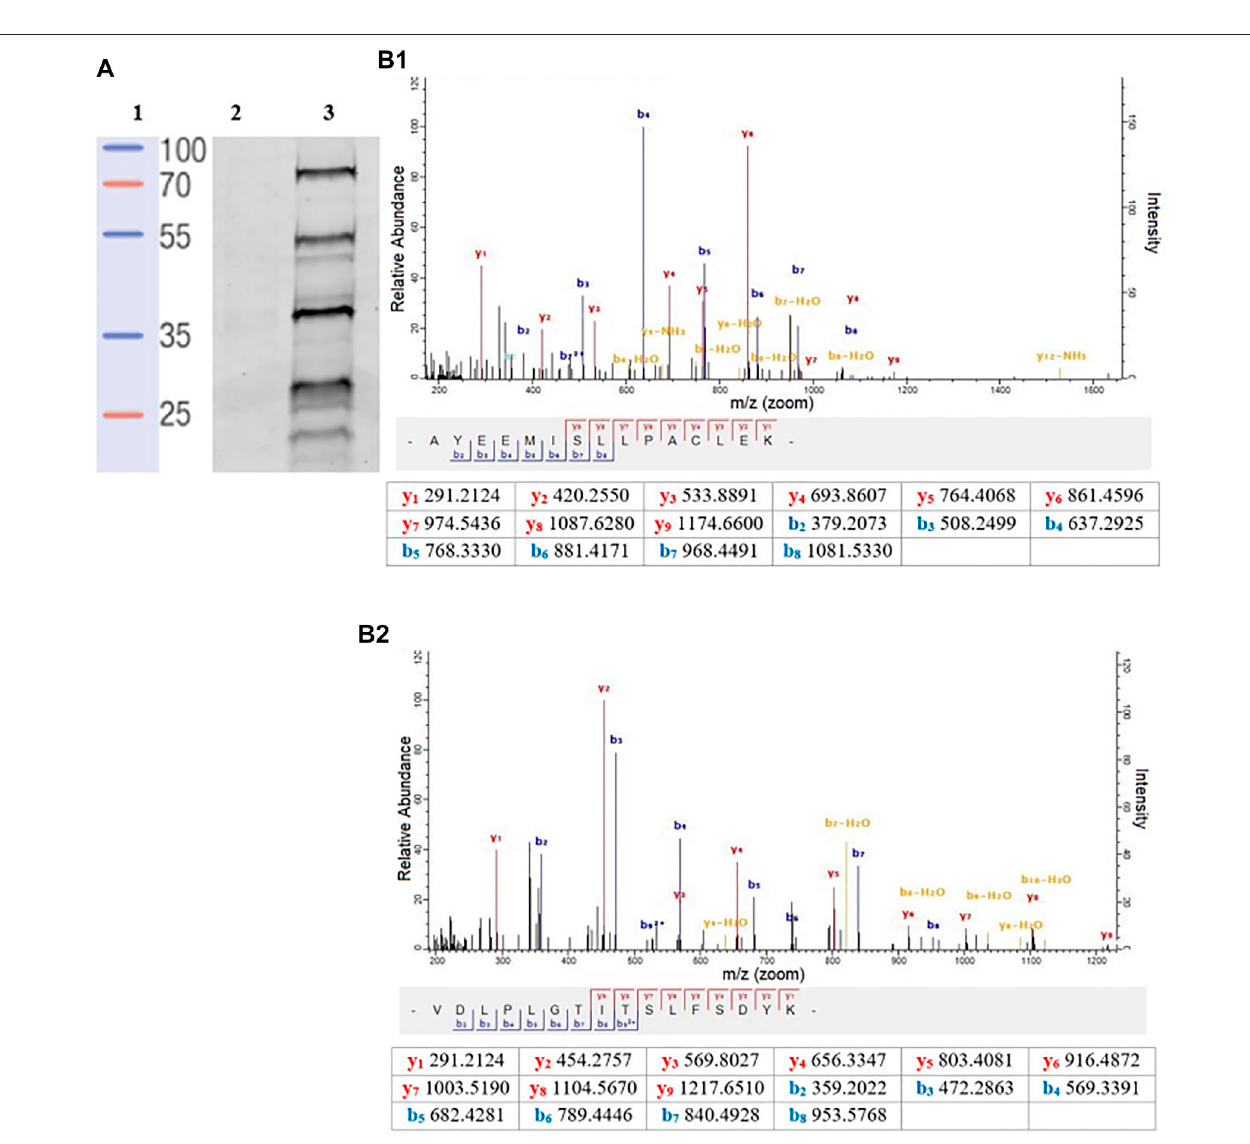
FIGURE 3 | (A) In-gel fl uorescence analysis (emission at 560 nm) of the competitive ABPP between FP-biotin conducted to compare af fi nity. Lane 1: Protein ladder. Lane 2: FP-biotin (4 μ M) was incubated in a L. mexicana promastigote lysate (1 mg/ml) for 60 min at rt. Subsequently, TAMRA-FP (1 μ M) was added, and the mixture was incubated for a further 15 min followed by SDS-PAGE and fl uorescent imaging. Lane 3: Labelling of TAMRA-FP (1 μ M) in L. mexicana promastigote lysate (1 mg/ml). (B) A representative MS/MS spectrum of a tryptic peptide of carboxypeptidase LmxM.18.0450 (B1) and prolyl oligopeptidase LmxM.36.675